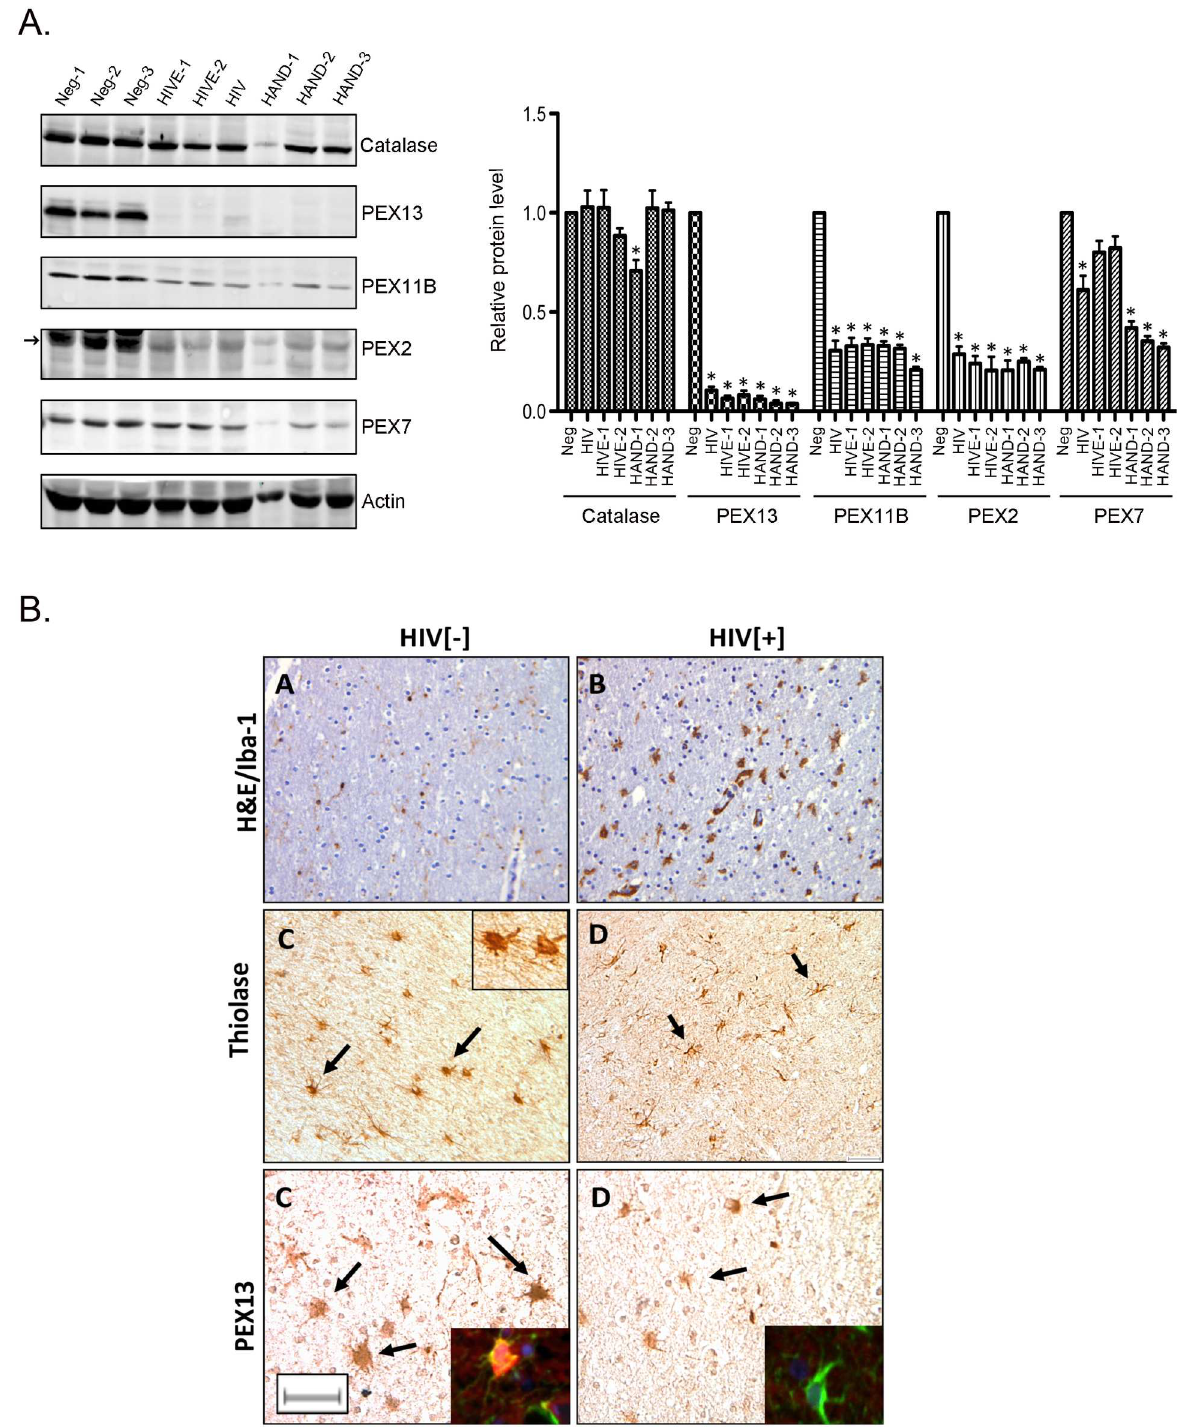
Fig 5. HIV-1 induces loss of peroxisomal proteins in brain tissue. A. Lysatesfrom braintissuefrom HIV negative (Neg-1-3), HIV positive(HIV), HIV positivewithencephalitis(HIVE-1-2) andHANDpatients (HAND-1-3) weresubjectedto immunoblottingwithantibodies to catalase,PEX2, PEX7, PEX11B,PEX13andactin. Therelativelevelsof peroxisomalproteins(compared to actin)wereaveragedand plotted.N = 3 (triplicatefrom same sample). Error bars representstandarddeviationof the mean. * p < 0.05.B. Immunodetection peroxisome proteinsin frontallobematerialfrom uninfected (HIV[-]) andHIV-infected (HIV[+]) patients.Peroxisomes werelabeledwith rabbitantibodiesPEX13or thiolaseandmicrogliaweredetectedusingrabbit anti-Iba-1. Most of the cellsthat stainintenselyfor thiolaseand